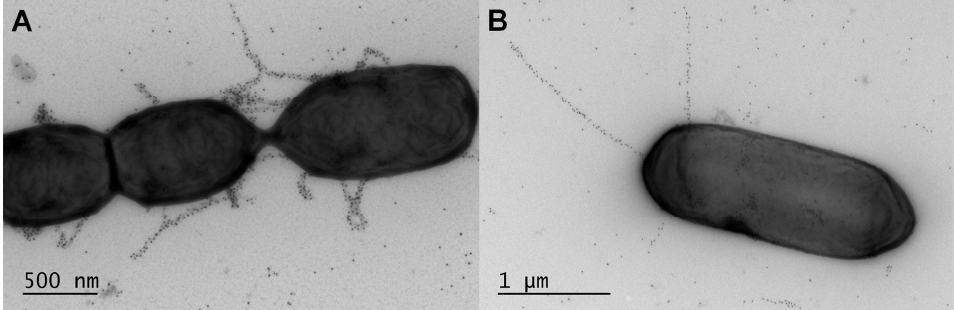
Figure 3. Visualization of native sortase-dependent piliation in lactobacilli by immuno-electron microscopy. Immunogold pilin-protein labeling and electron microscopy (EM) of bacterial cells were done using established techniques [89]. Long protruding structures representing the SpaCBA pili in L. rhamnosus GG ( A ) and LrpCBA pili in L. ruminis ATCC 25644 ( B ) are identified by immuno-labeling first with polyclonal antibody specific for the backbone-pilin subunit (SpaA and LrpA, respectively) and then protein A-conjugated gold particles (10 nm in diameter; black dots), followed by negative staining and electron microscopy (EM). Scale bars for each electron micrograph image are found at the bottom-left corner.